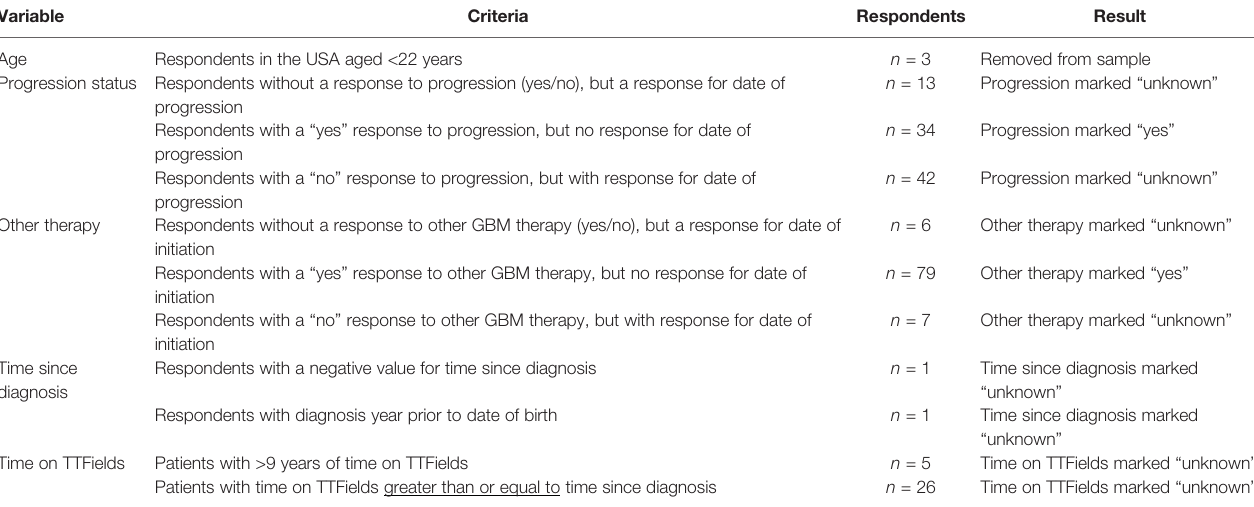
TABLE 1 | Data cleaning criteria, number of respondents with unclear results, and action taken.